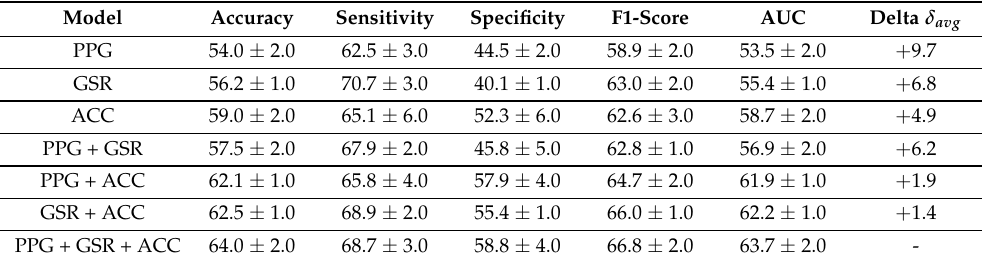
Table 3. Quantitative model performance metrics for exhaustive unimodal and multimodal cases with CB.